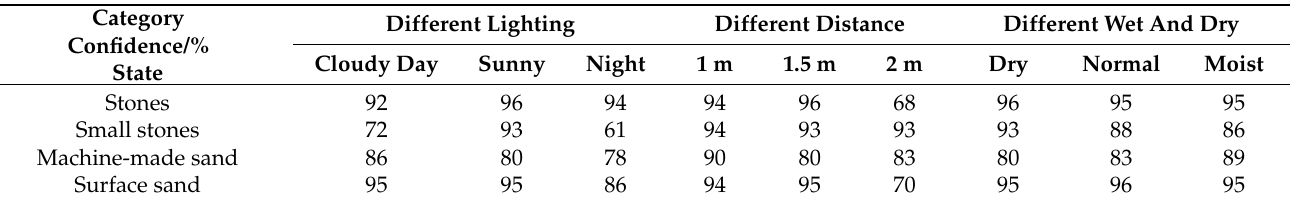
Table 1. Detection confidence in different sates.